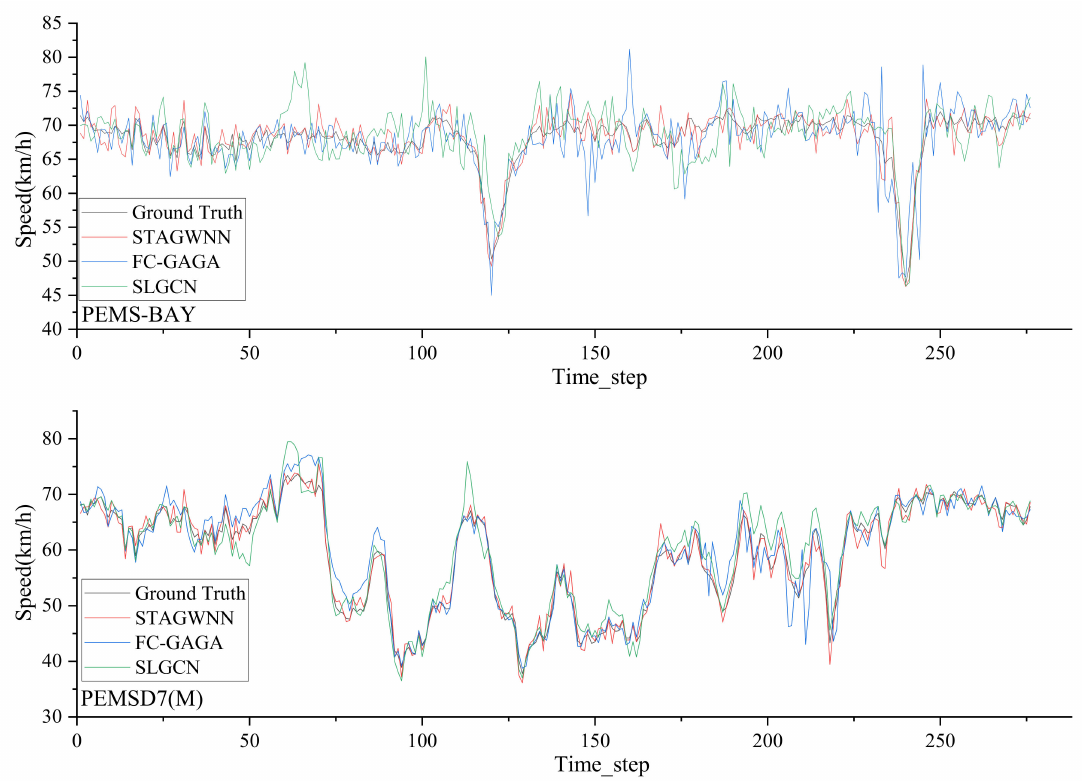
Figure 9. Comparison of predicted and true values of the speed of the two